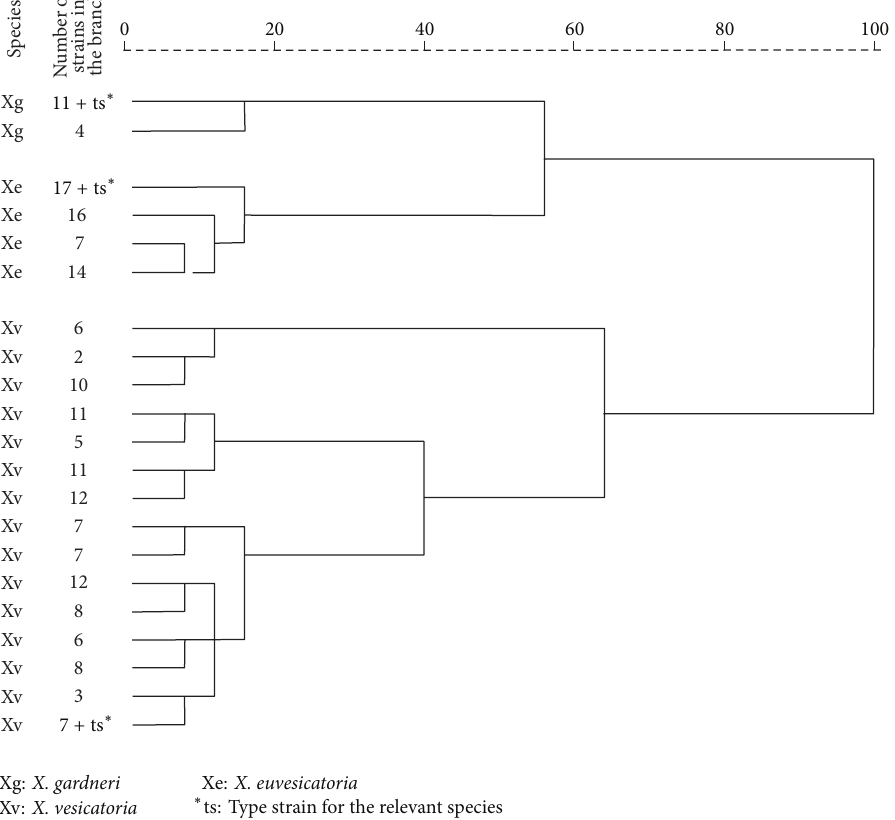
Figure 2: Cluster analysis of the Bulgarian strains of genus Xanthomonas isolated from pepper, tomato, and weeds based on their differentiating